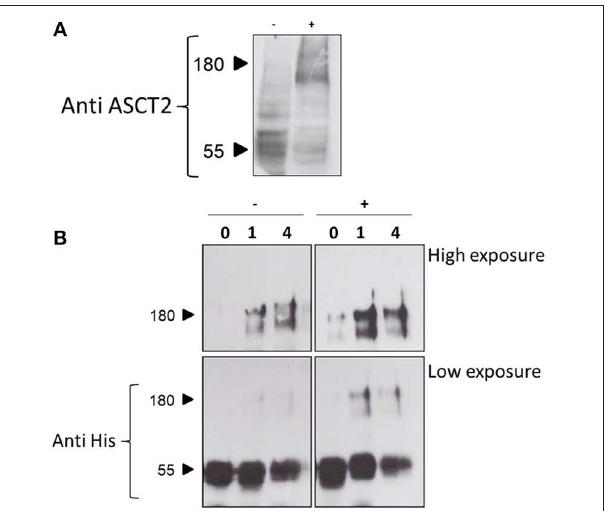
FIGURE 10 | Cross-linking analysis of hASCT2. In (A) , immunoblot analysis of protein extracted from HeLa cells treated with 0.75% formaldehyde as described in Materials and Methods. Samples (50 µ g total lysate) were subjected to SDS-PAGE and immunoblot with anti-hASCT2 (1:1,000); (–), control without formaldehyde; ( + ), sample treated with formaldehyde. In (B) , immunoblot analysis of purified hASCT2 treated with 1 or 4% formaldehyde as described in Materials and Methods. Samples were subjected to SDS-PAGE and immunoblot with anti-hASCT2